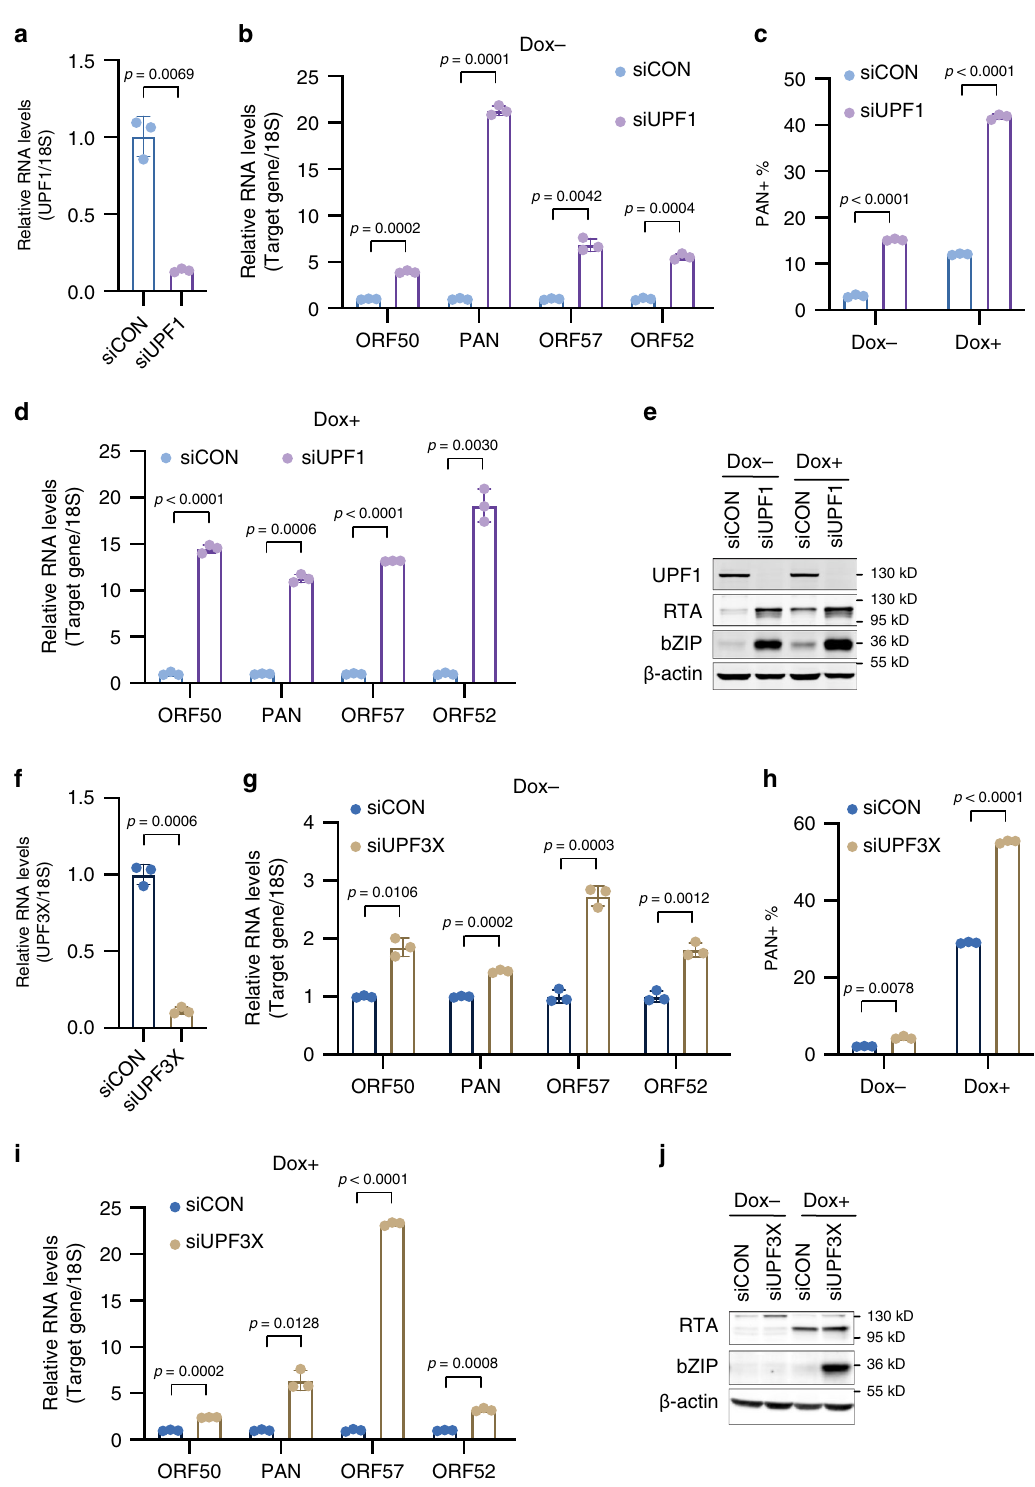
(RNA FISH-FLOW). While ~3% of siCON-treated TREx- BCBL1-RTA cells expressed PAN RNA, its expression was observed in ~14% of siUPF1-treated cells (Fig. 3c and Supple- mentary Fig. 7a). Thus, in both iSLK.219 and TREx-BCBL1-RTA cells knockdown of UPF1 increases spontaneous reactivation. The effects of UPF1 knockdown on Dox-induced lytic gene expression in TREx-BCBL1-RTA cells was also determined. Total RNA and protein was isolated from siCON- or siUPF1-treated